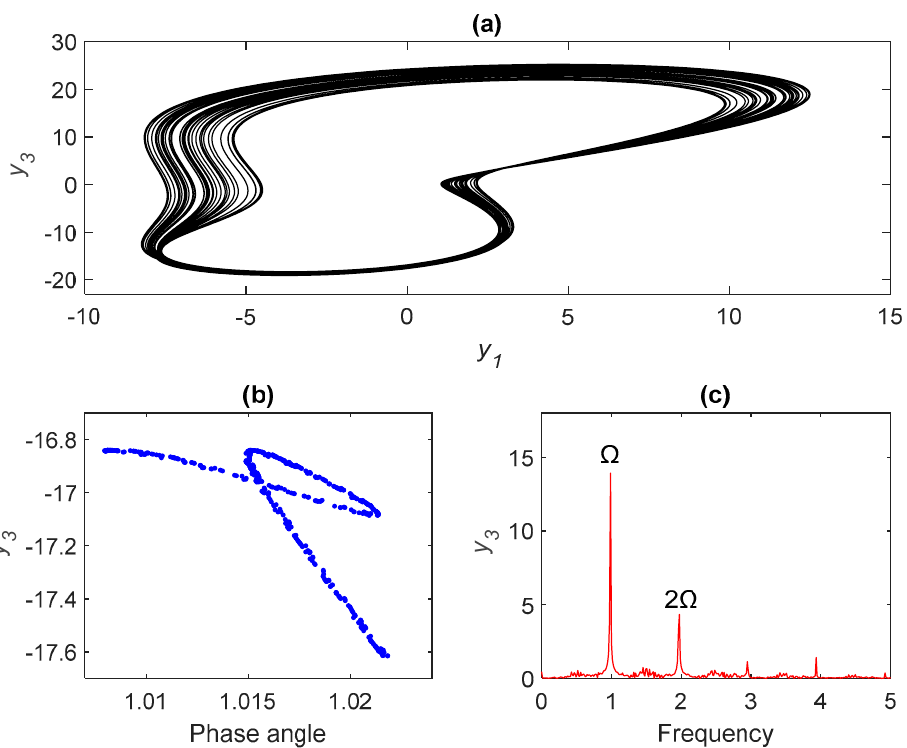
Figure 4. Period-4 orbit for σ = 4.205: ( a ) phase portraits, ( b ) Poincare maps, and ( c ) frequency spectra.